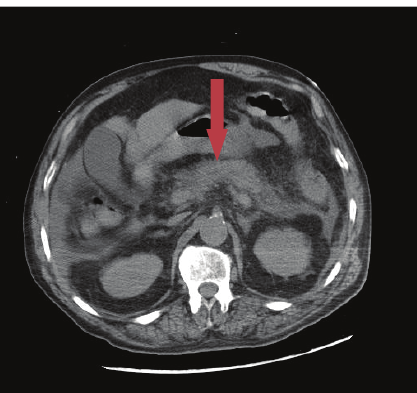
Figure 1: Axial cut of abdomen on day 1: arrow showing mildly ede- matous pancreas, with moderate peripancreatic infiltrative changes secondary to moderate acute pancreatitis. Figure 2: Axial cut of abdomen on day 7: red arrow pointing at